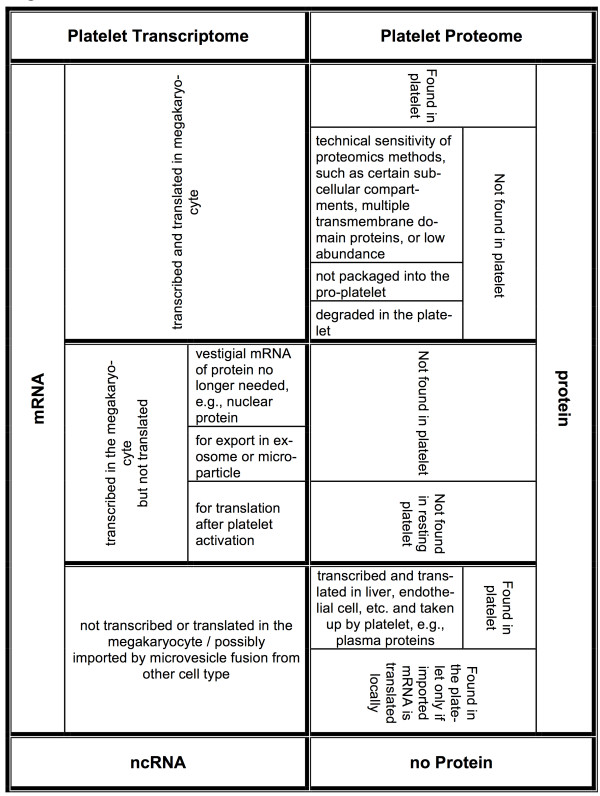
Relationships between the platelet transcriptome (left) and proteome (right). The entries comprise some of the known causes that may underlie the observed discordance between platelets mRNAs and platelet proteins